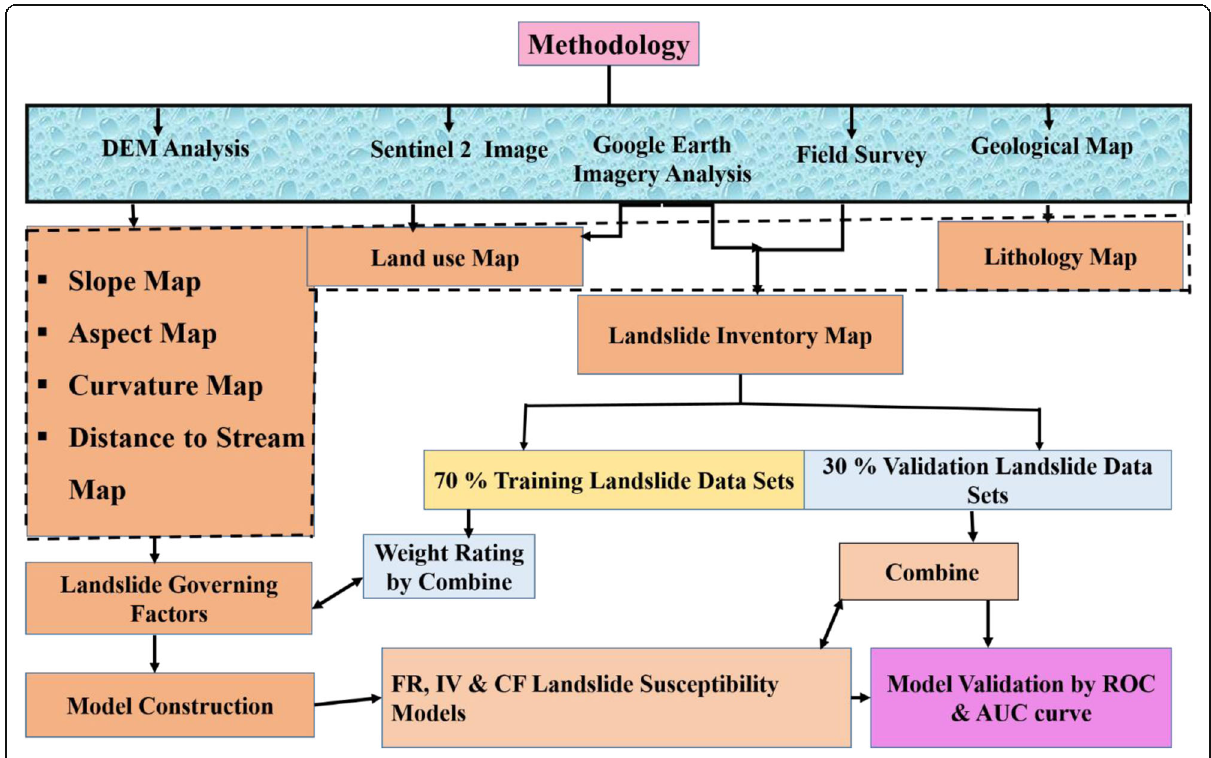
Fig. 3 General flow-charts for the methodology of the study